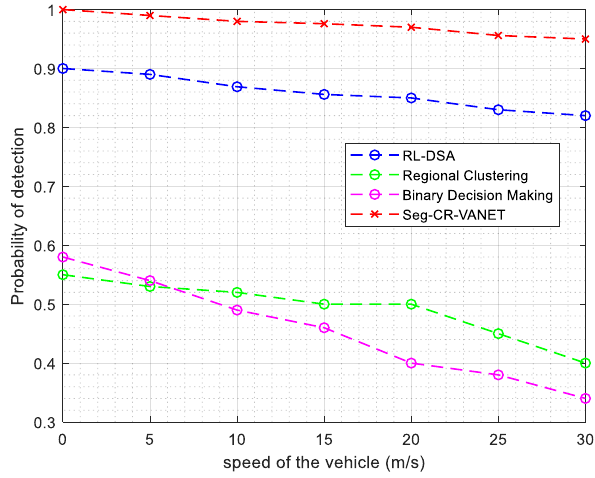
Figure 5. Comparison on probability of detection.